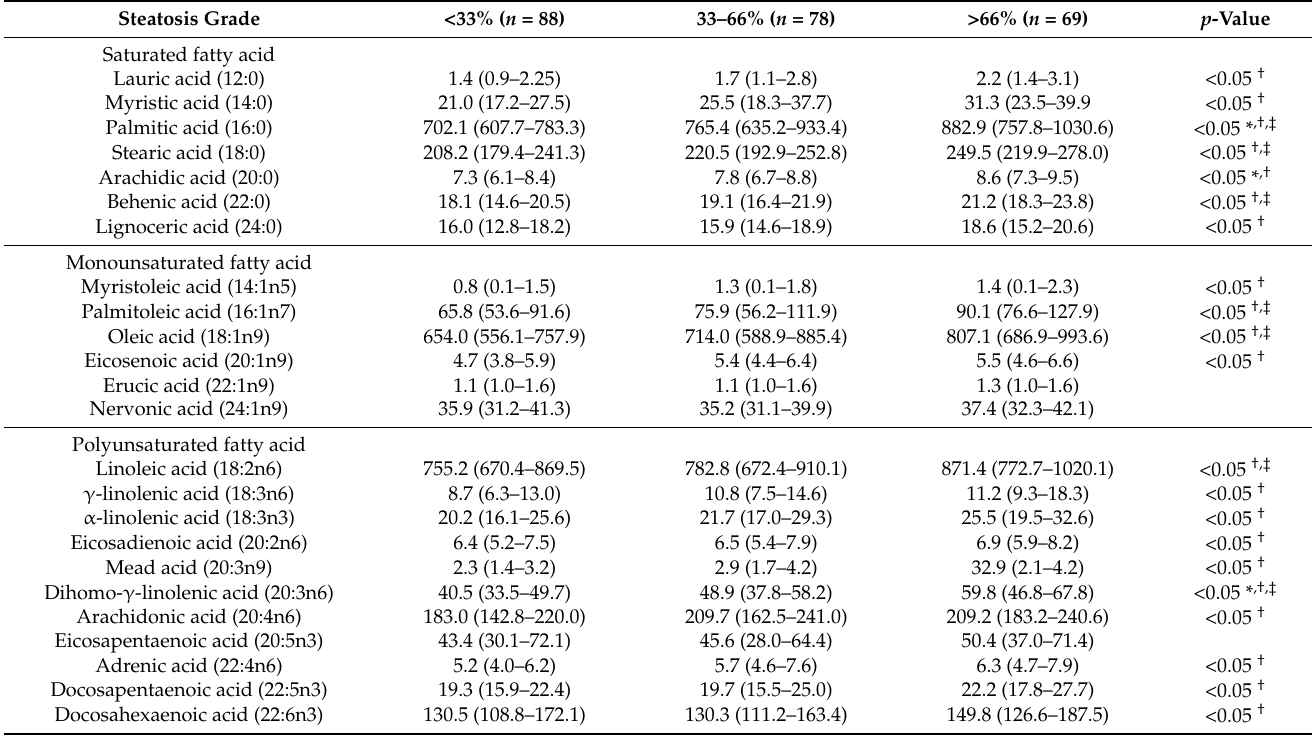
Table 7. Plasma fatty acid composition ( µ g/mL) (steatosis grade).